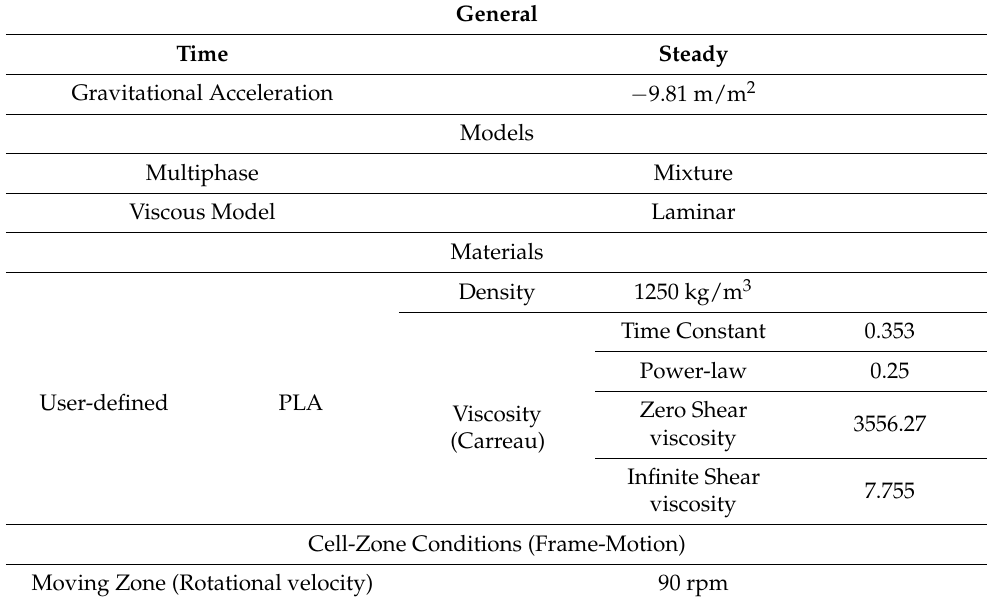
Table 1. Parameter settings in Fluent [17,18].